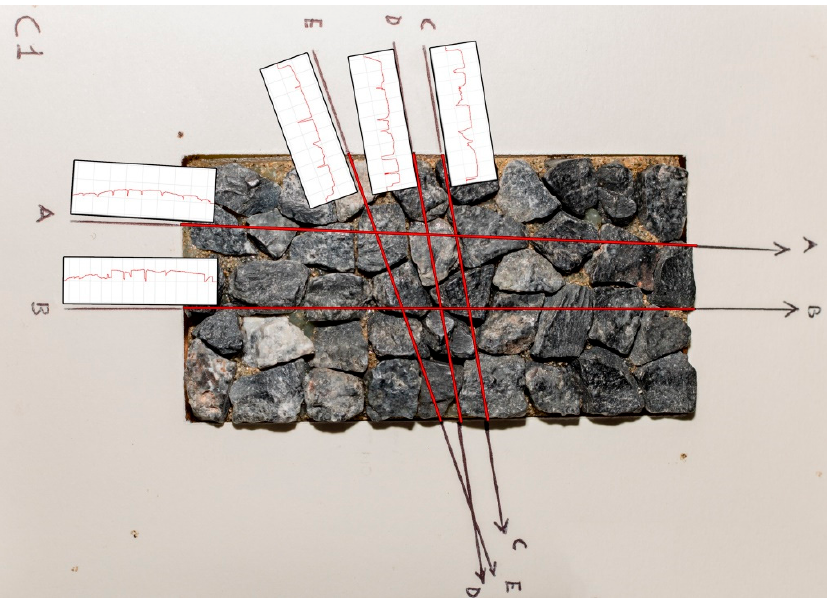
Figure 2. Specimen equipped with preset mask by profilometric alignments (longitudinal A-A, B-B; and crosswise C-C, D-D, E-E) for surface texture investigation.